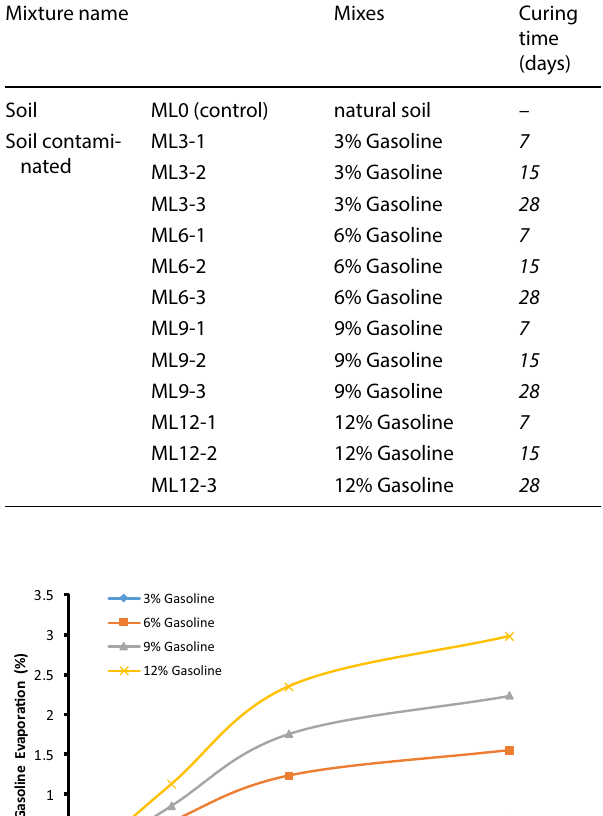
Table 4 Physical and mechanical properties of the soil